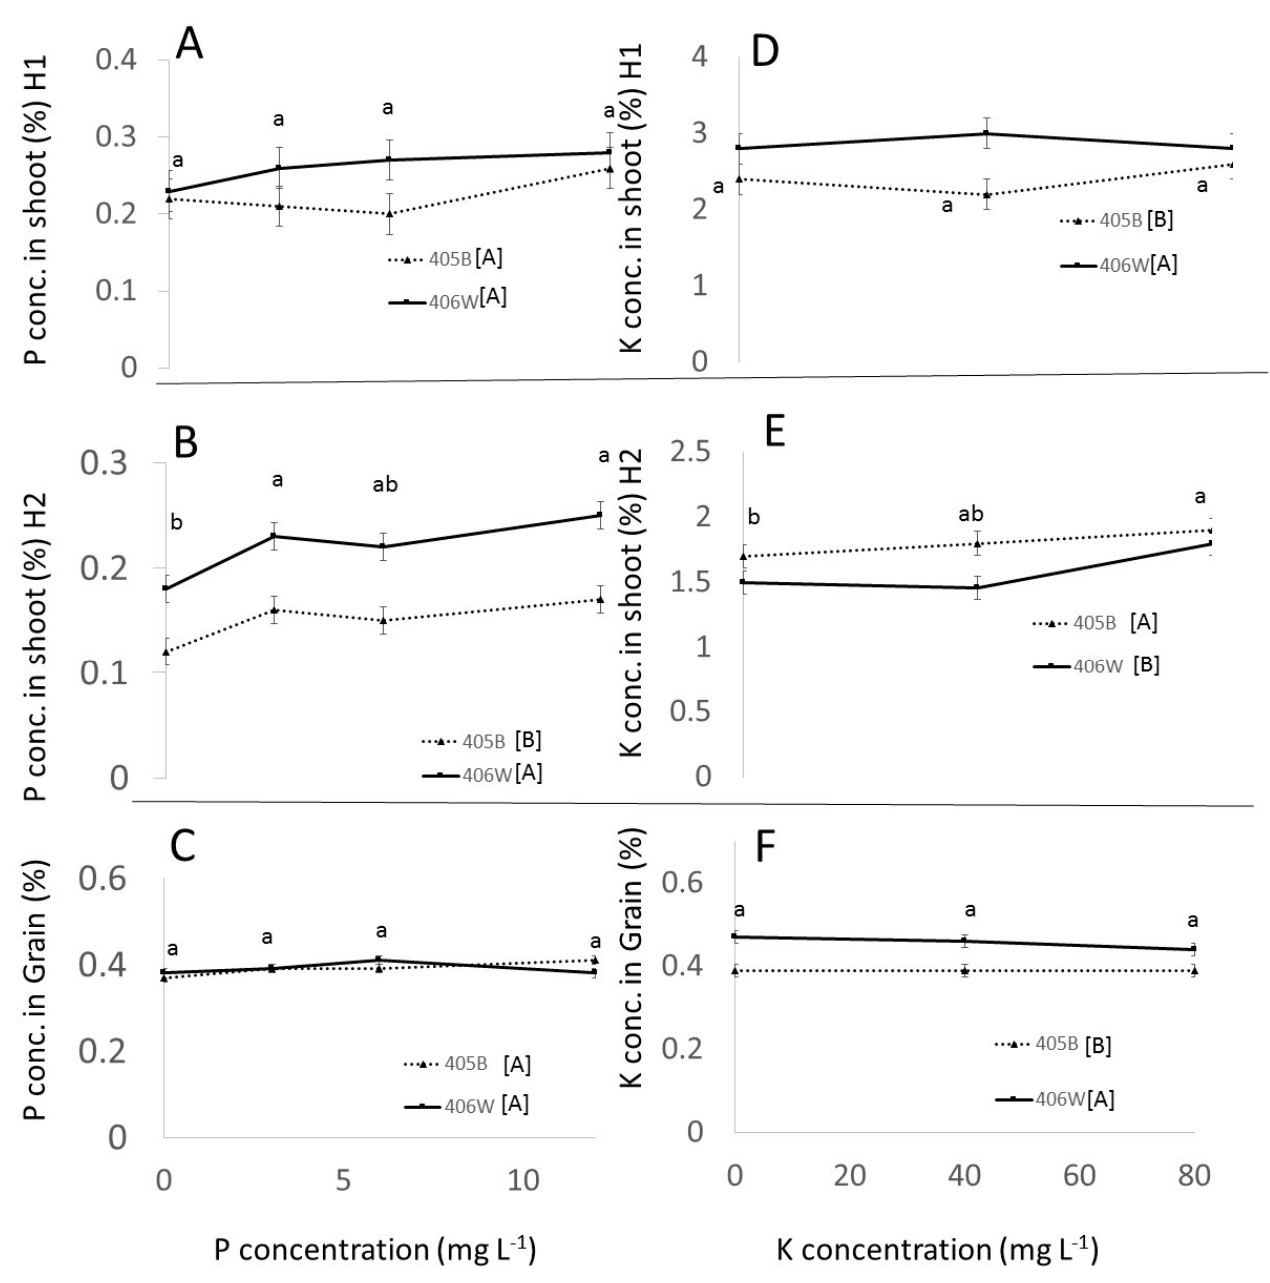
Figure 4. Shoot P concentration at flowering ( A ), shoot P concentration at maturity ( B ), and grain P concentration ( C ) in the summer field experiment by P fertigation level. Shoot K concentration at flowering ( D ), shoot K concentration at maturity ( E ) and grain K concentration ( F ) in the summer field experiment by K fertigation level. Dashed line represents 405B genotype, and solid line represents 406W genotype. Different letters represent significant (<0.05) differences for main effects. Lower case letters adjacent to the trend line represent the results of the Tukey test for N concentration averaged across genotypes, and capital letters adjacent to the legend represent the results of the Student- t test for the two different genotypes.